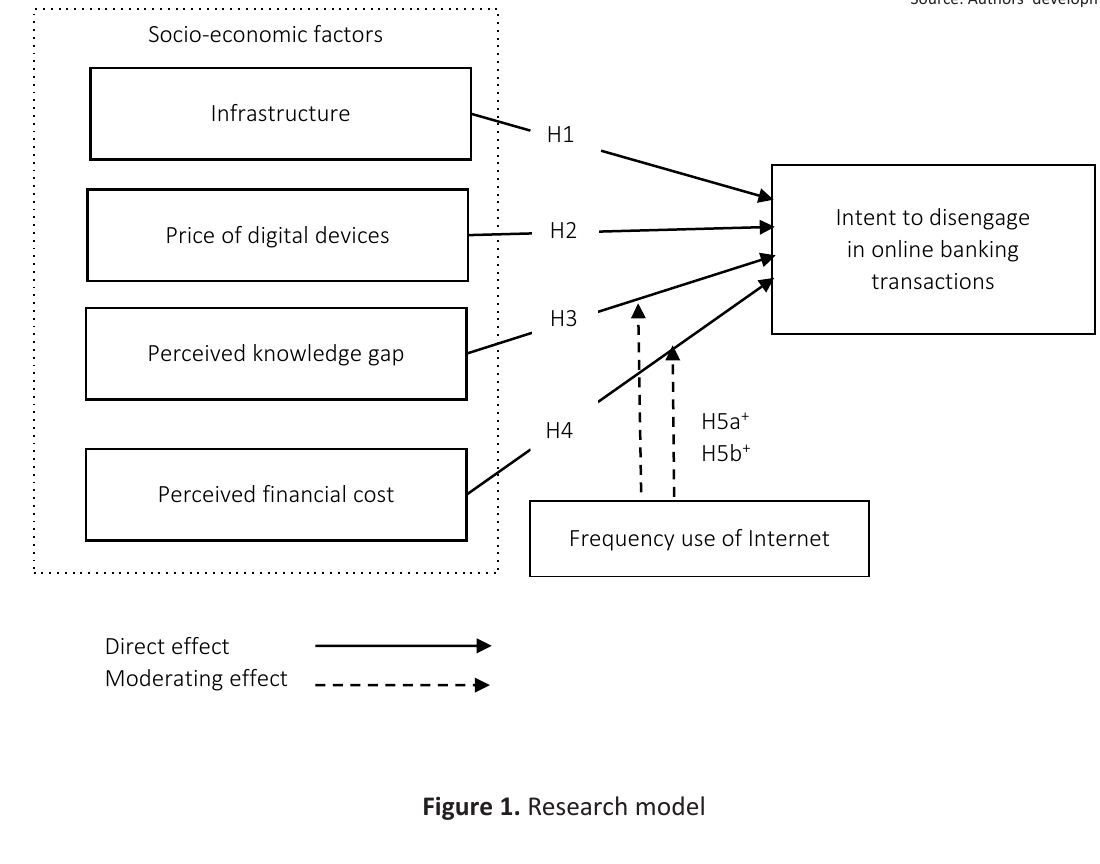
Figure 1. Research